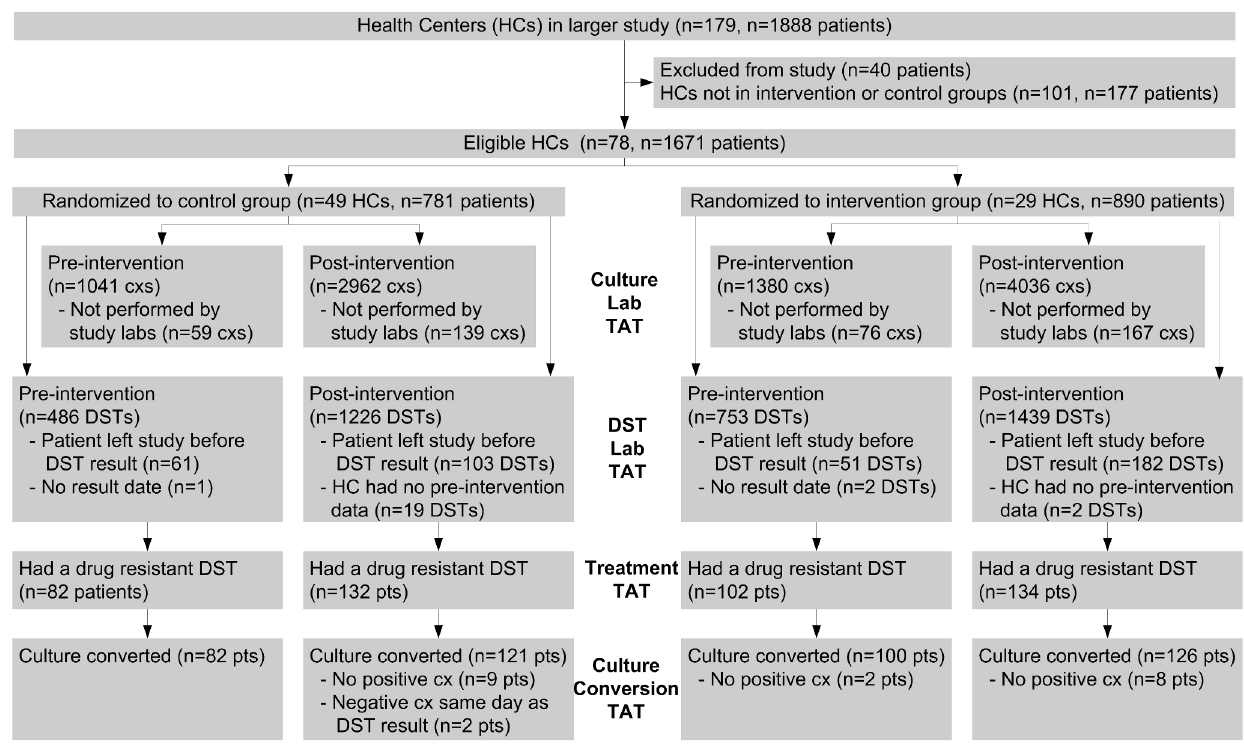
Figure 2. Flow of participants, cultures and DSTs through trial. The Pre-intervention groups represent baseline data collection prior to the RCT which was used to correct for baseline differences between sites during the analysis. Cx is sputum culture, DST is drug sensitivity test.